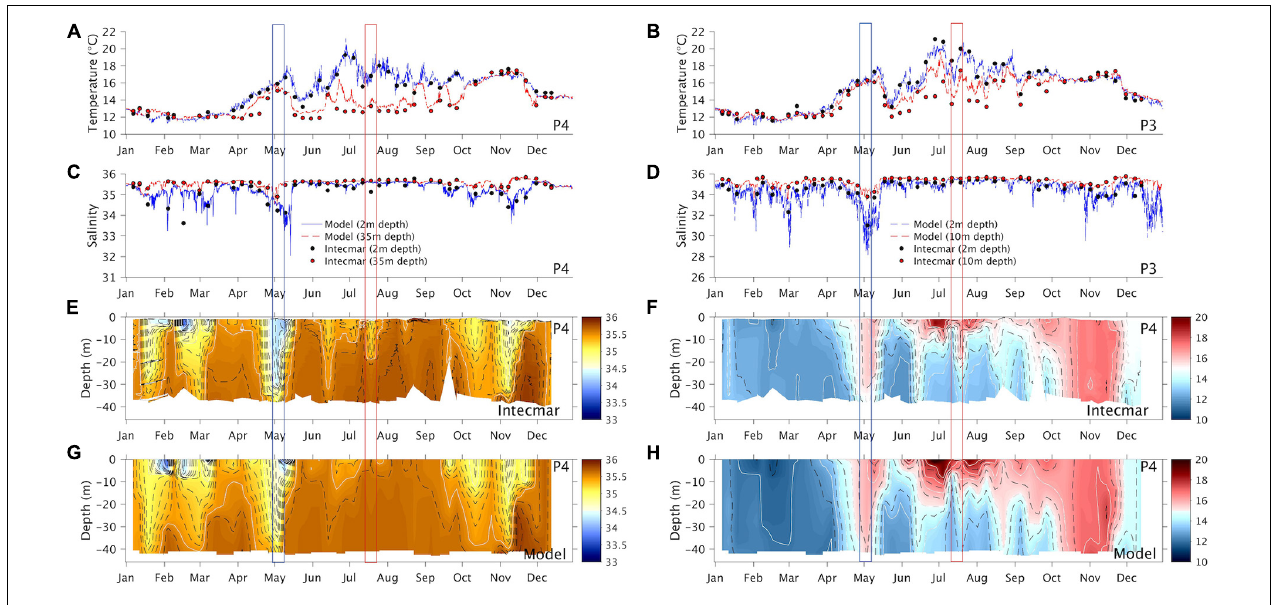
FIGURE 4 | Comparison of modeled (dashed line) and measured (INTECMAR; dots) surface and deep temperature and salinity data for (A,C) P4 and (B,D) P3 INTECMAR stations (see Figure 2 for stations location). Comparison of 2015 yearly evolution of salinity vertical profile for (E) INTECMAR P4 station and (G) the modeled P4 station. (F,H) Same as (E,G) for temperature ( ◦ C). Blue/red boxes represent the downwelling/upwelling events